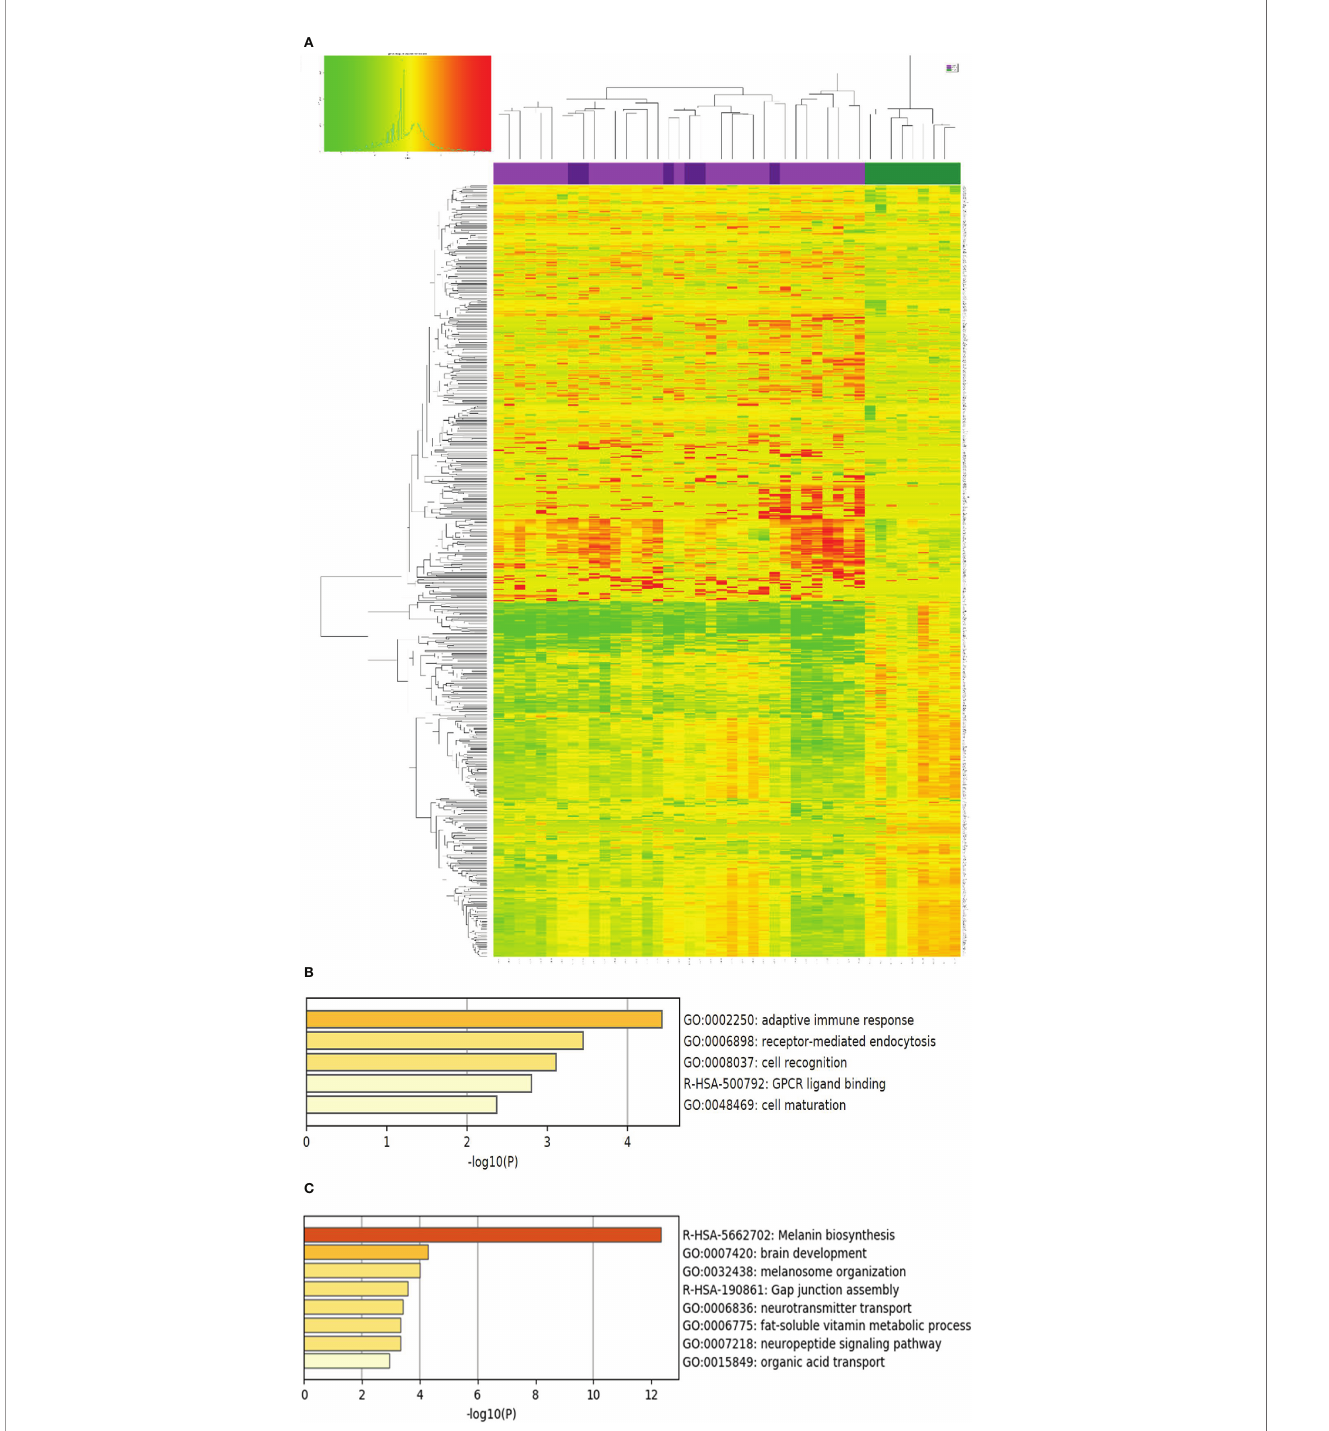
FIGURE 1 | Genes with differential expression between vitiligo lesional skin and normal health skin. (A) The expression of the 723 genes with signi fi cant differential expression (> 2 fold change, p<0.05) compared with normal healthy skin (NHS, shown in green on the top panel, N=9), lesional skin of segmental vitiligo (shown in dark purple, N=6), and non-segmental vitiligo (bright purple, N=30) is presented as a heat map with non-supervised clustering analysis. Red and green color designate up or down regulation, respectively, of the gene in that particular sample compared to the average of healthy normal skin. The complete list of these genes are included in Supplemental Table 1 . (B, C) Biological pathways represented by genes up and down regulated in LS over healthy normal skin, respectively. The p values were obtained by Metascape